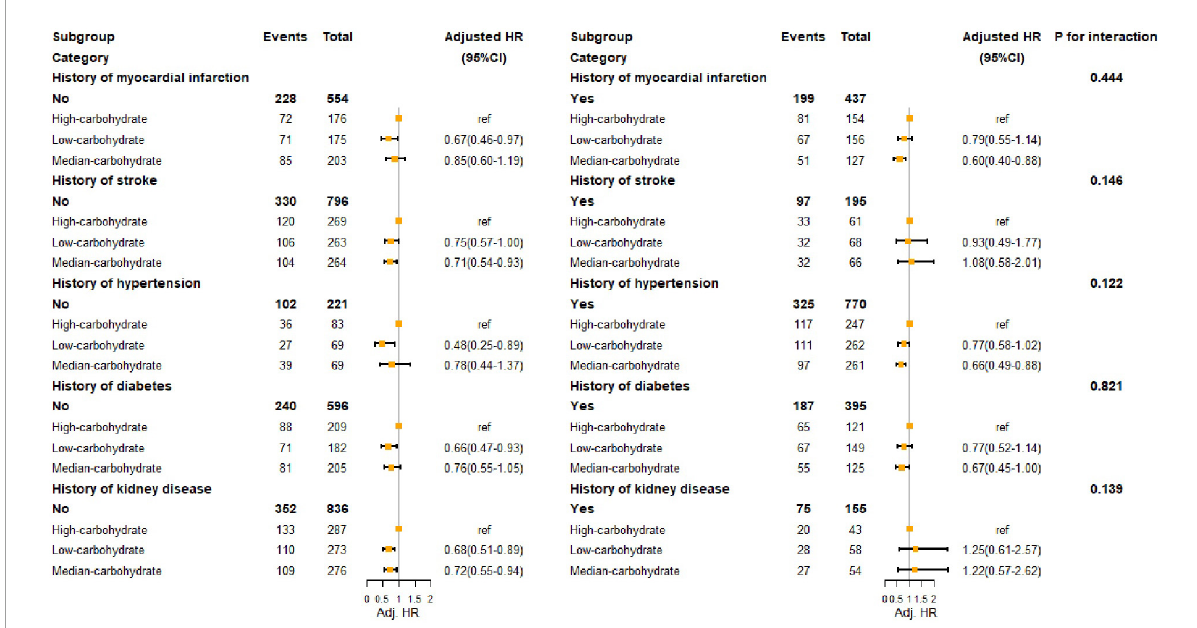
FIGURE3 Hazard ratio of all-cause death of HF population with different comorbidities. MI, myocardial infarction; CKD, chronic kidney